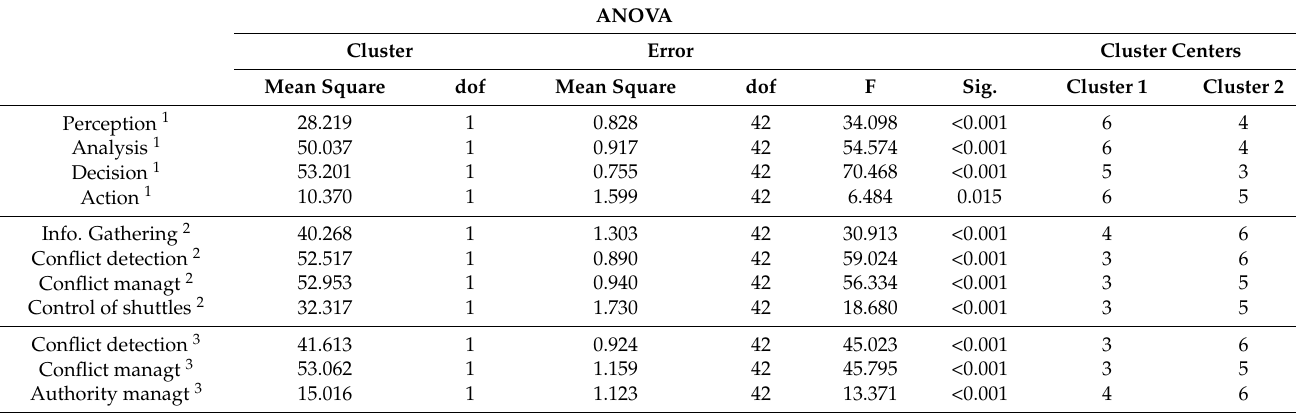
Table 7. ANOVA result of the clustering according to Human-Machine cooperation questionnaire and the final cluster